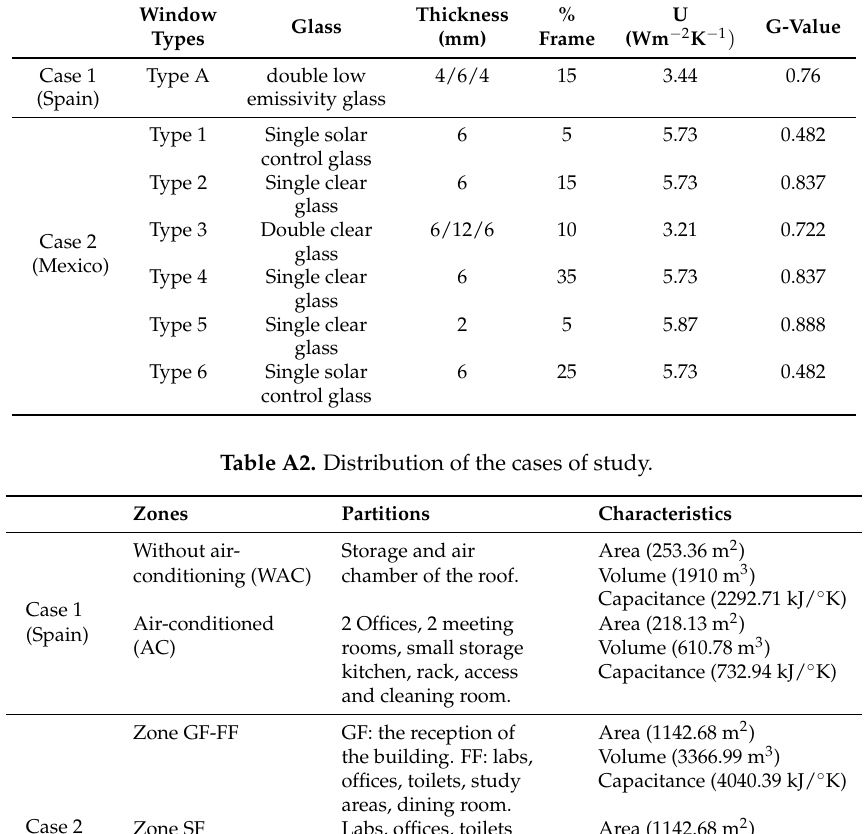
Table A1. Thermal and structural properties in windows.